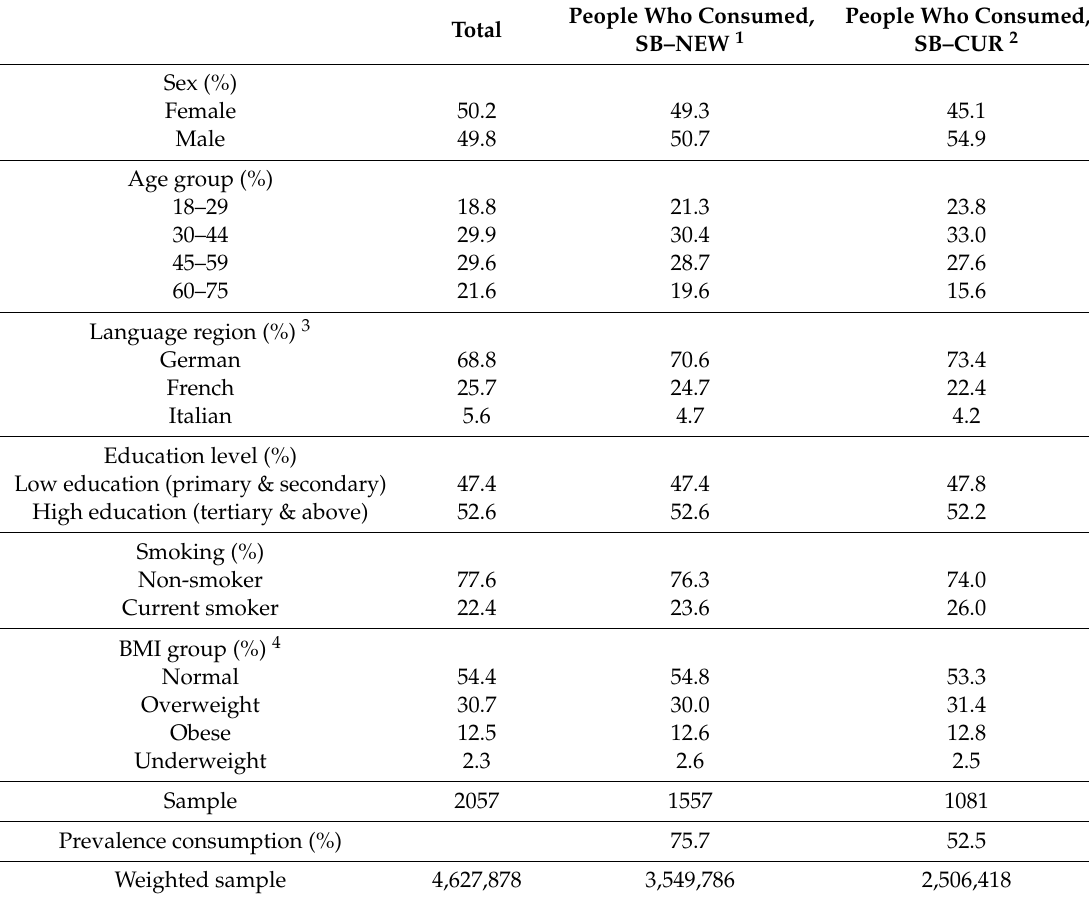
Table 2. Sociodemographic characteristics of the study participants, menuCH 2014.